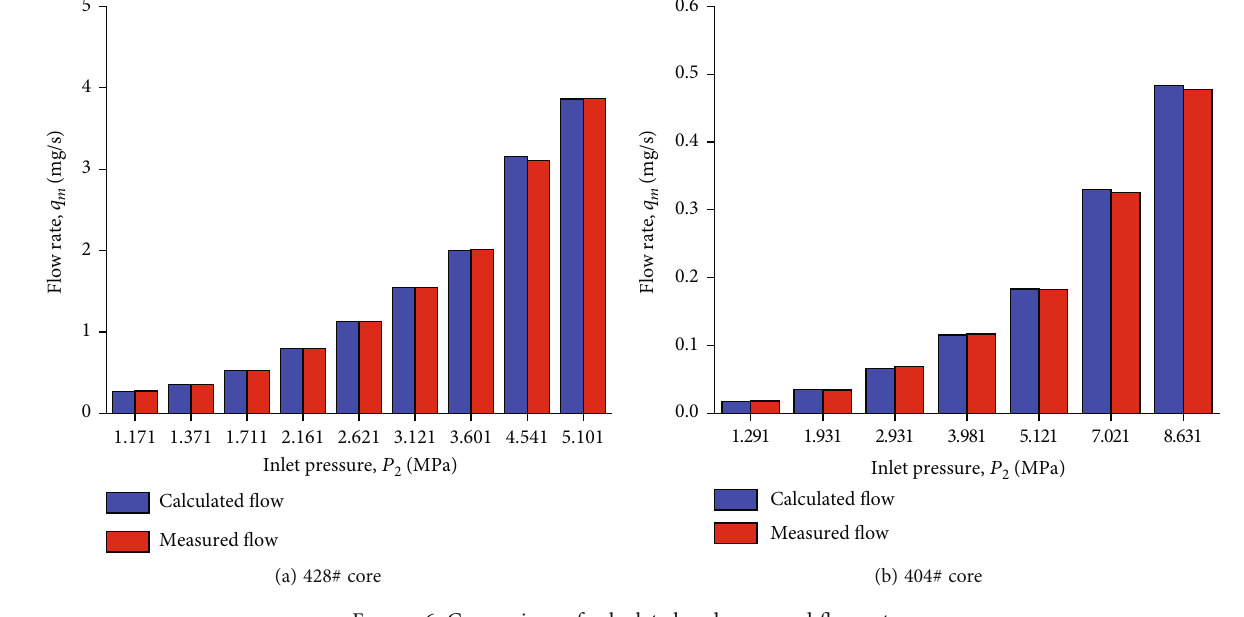
Figure 6: Comparison of calculated and measured fl ow rates.